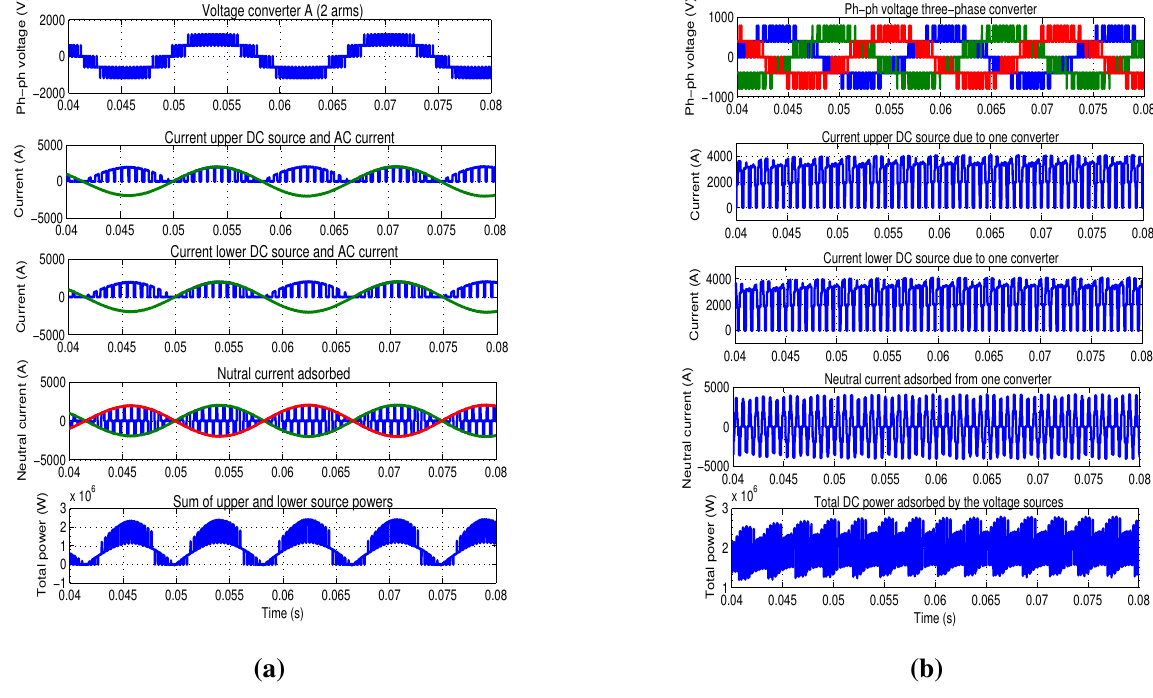
Figure 7. Single-phase and three-phase converters waveforms with constant voltage generators and with P m = 0 . 5 MW, P t = 1 MW. ( a ) Single-phase converter waveforms; ( b ) a single three-phase converter